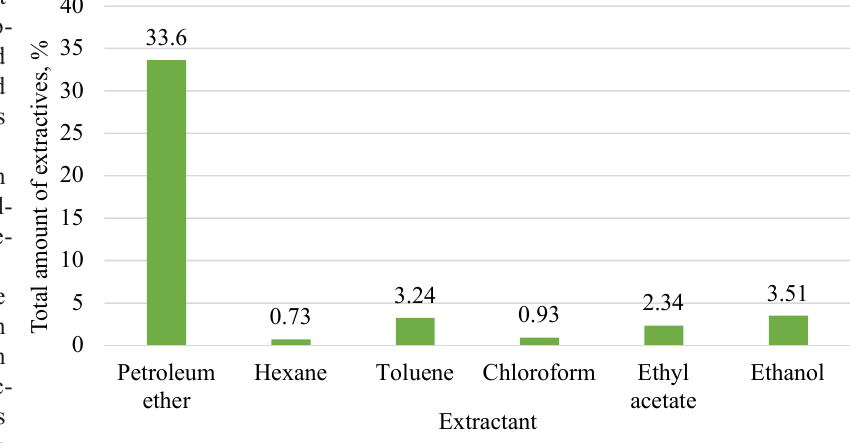
Fig. 3. Graphic dependence of the total amount of extractives in birch buds on the extractant used